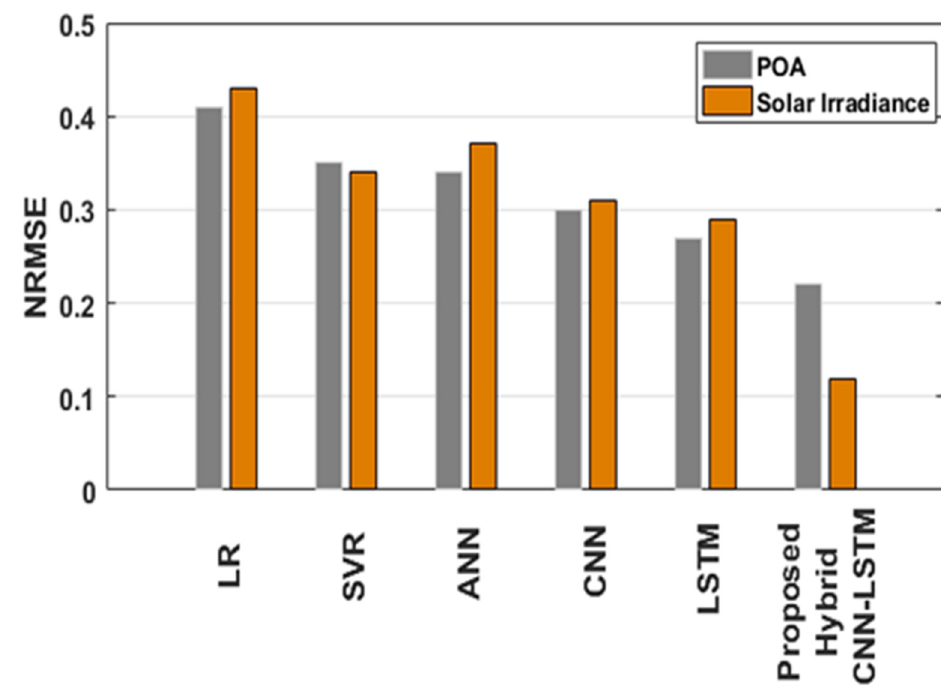
Figure 12. Comparative result. Table 6. Comparison of the results of the study method with the state of the art. Ref.